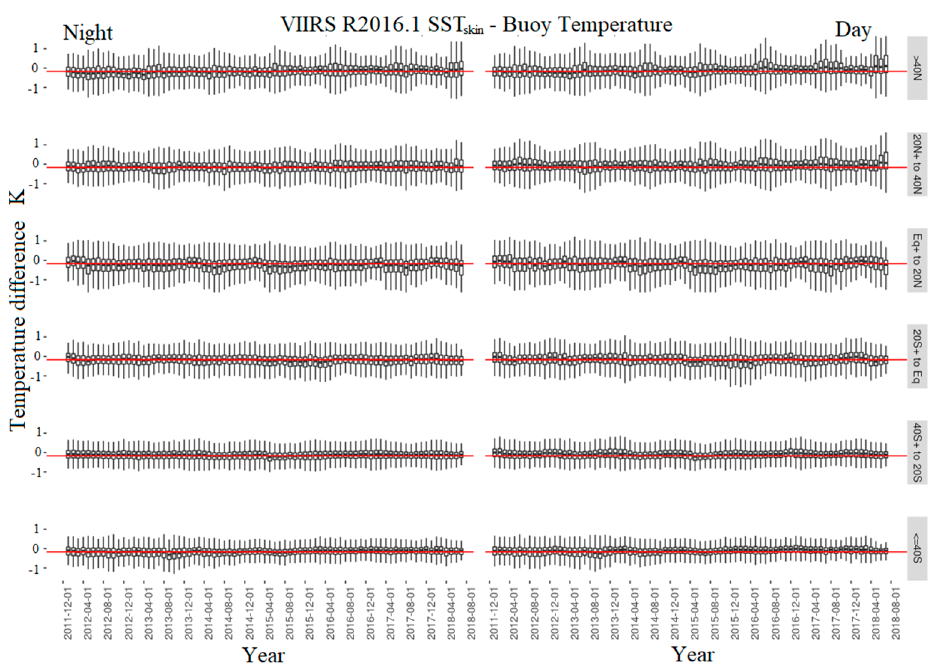
Figure 11. VIIRS SST skin values relative to subsurface temperatures measured from buoys separated into six latitude bands, as shown at right. The box represents the inter-quartile range, the black bar is the monthly median, and the whiskers show the outliers. The red horizontal line at − 0.17 K is the expected cool skin offset. Data are for best quality retrievals.